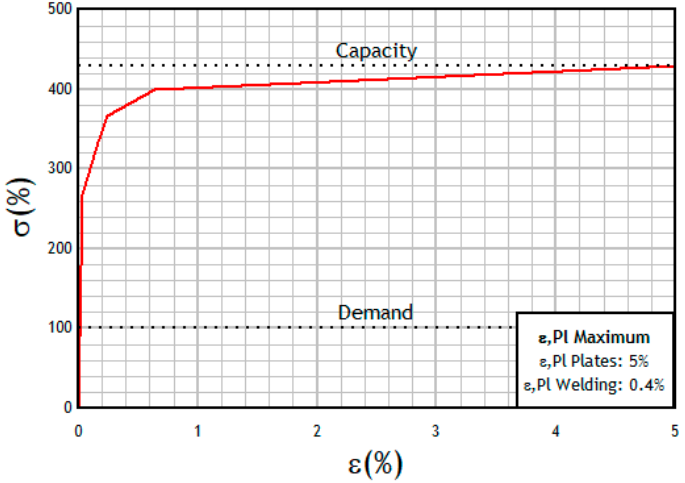
Figure 9. Percentage of strength vs. percentage of strain 8ES EPC NP CP-DP-ST.